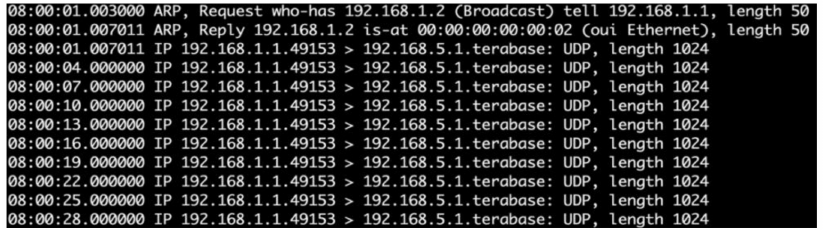
Figure 12. Routing routes for Distributed Denial-Of-Service (DDoS) attacks from host0–host2.